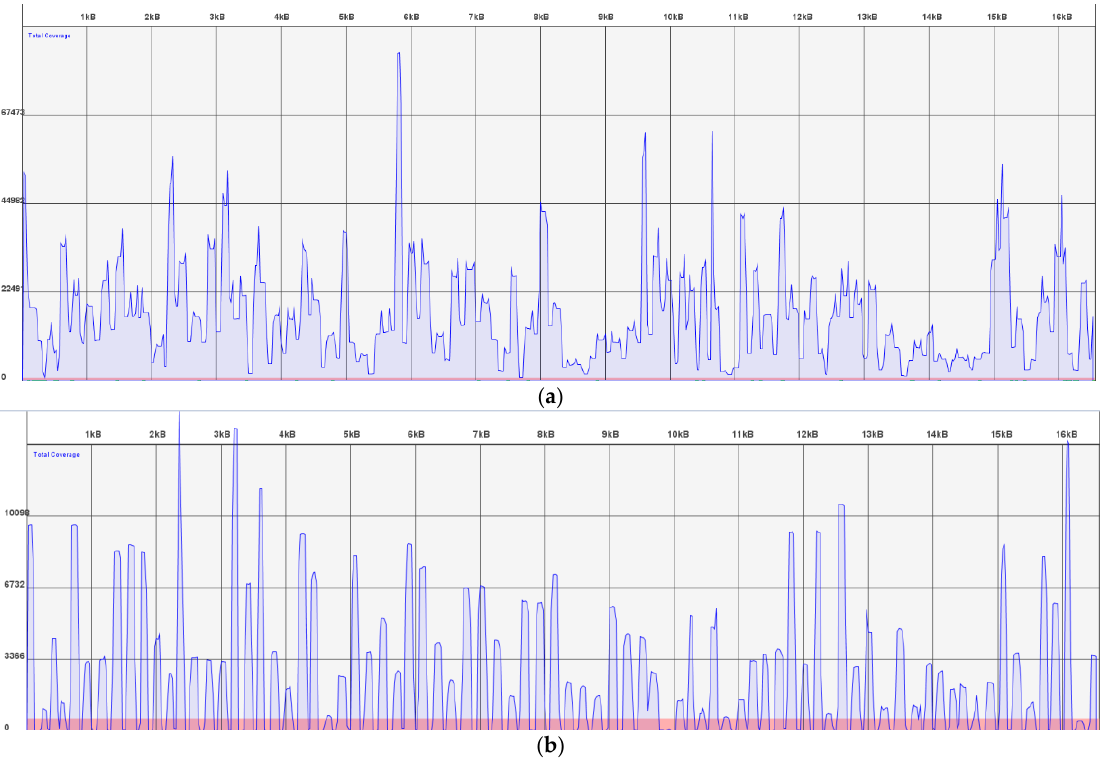
Figure 2. Linear coverage graphs. The x-axis shows the mitochondrial genome from position 1 – 16,569. The y-axis represents the number of usable reads sequenced. The pink shading shows the coverage threshold of 500 reads. ( a ) Bone 3 amplified well with full coverage for all amplicons. ( b ) Bone 5 is missing coverage for every other amplicon in the panel seen as a disconnected coverage map.